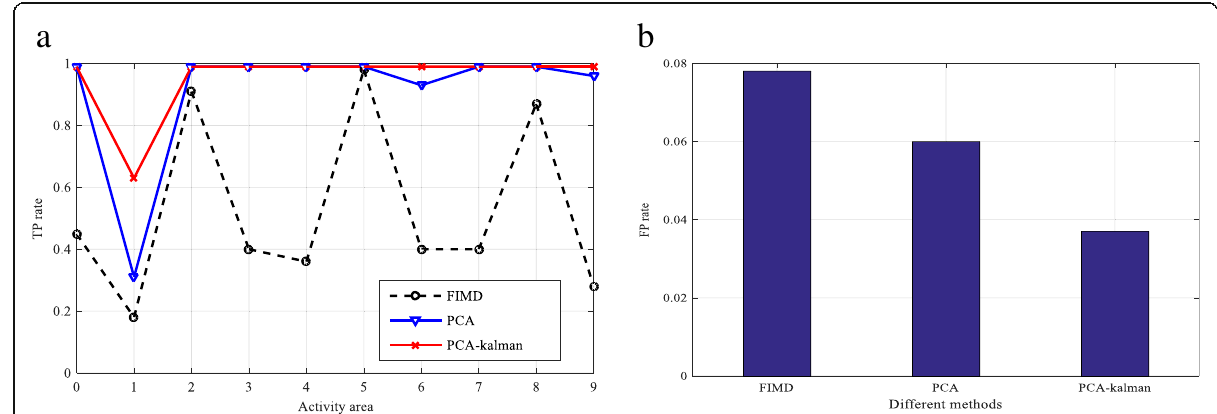
Fig. 12 Detection performance of FIMD and PCA-Kalman with regard to different activity areas. a TP of different activity areas. b Corresponding FP